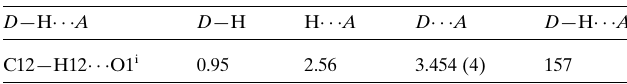
Table 2 Hydrogen-bond geometry (A˚ , (cid:3) ) for 2 .